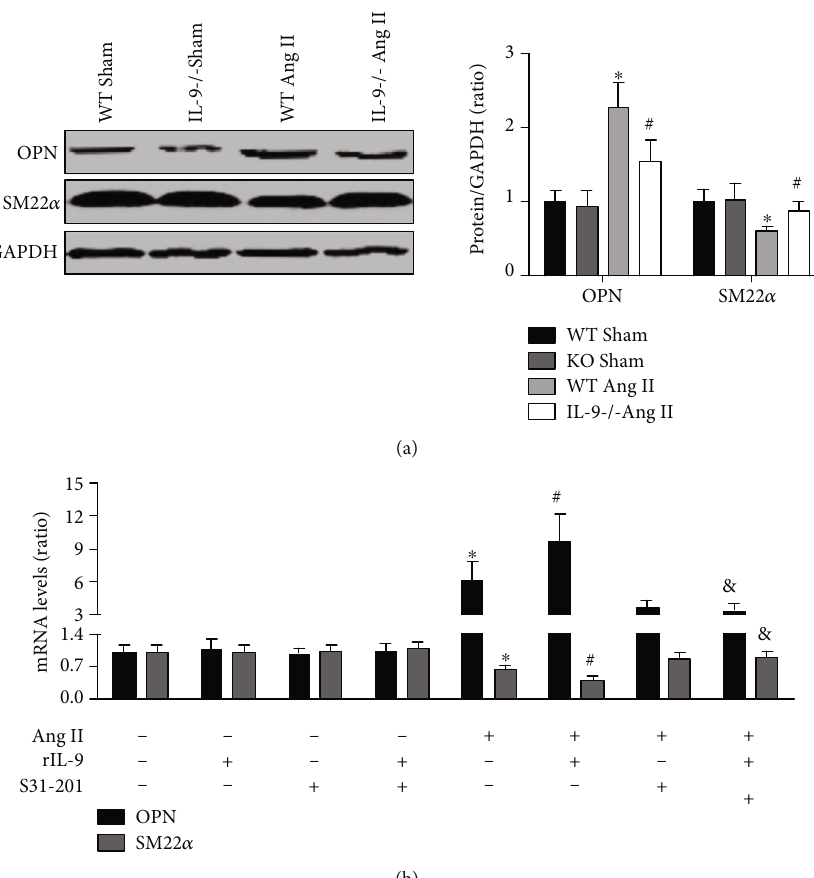
Figure 5: E ff ects of IL-9 KO on phenotypic transformation of smooth muscle. (a) Aortic OPN and SM22 α expressions for the four groups were measured. N = 5 in each group. ∗ p < 0 : 05 vs. the WT Sham group; # p < 0 : 05 vs. the WT Ang II group. (b) E ff ects of rIL-9 and S31- 201 on the OPN and SM22 α mRNA expressions of Ang II-treated SMCs. N = 5 in each group. ∗ p < 0 : 05 vs. the control group; # p < 0 : 05 vs. the Ang II group; & p < 0 : 05 vs. the Ang II+rIL-9